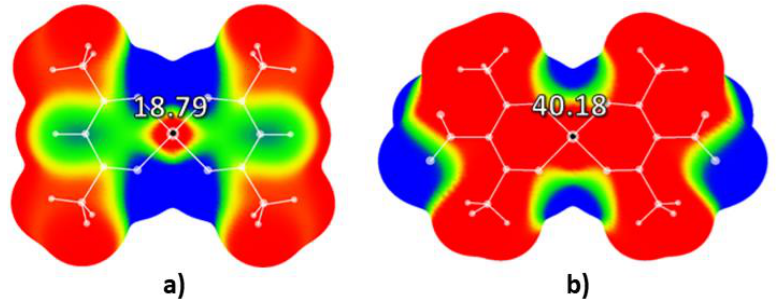
Figure 4. Calculated electrostatic potential maps for ( a ) bis(acetylacetonato) and ( b ) nitro-bis(acetylacetonato) oxovanadium (IV) complexes. Color ranges, in kcal/mol, are: red, greater than 6.28, yellow, from 0.00 to 6.28, green, from −6.28 to 0.00 kcal/mol, and blue, more negative than −6.28. Black dots represent critical points on the molecular surfaces.